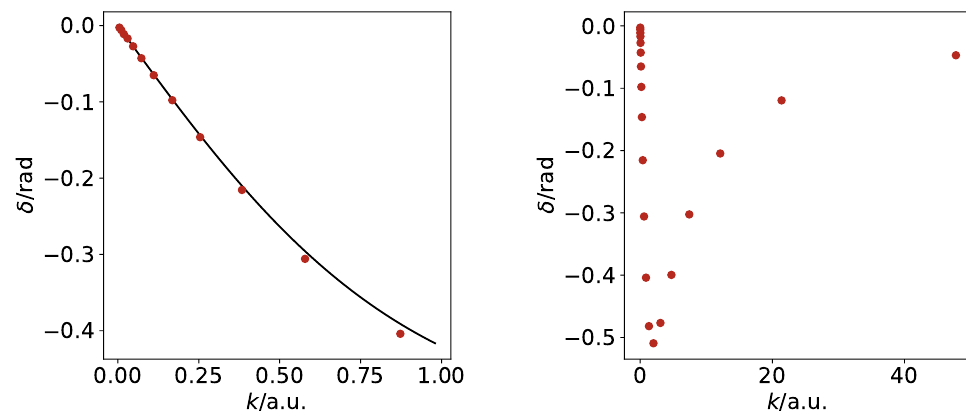
Figure 4. Positron–hydrogen s-wave scattering phase shifts in the static approximation calculated using a two-particle model (red circles), plotted over two contrasting ranges of k . The meaning of the black curve is the same as in Figure 3. Agreement with Figure 3 can be